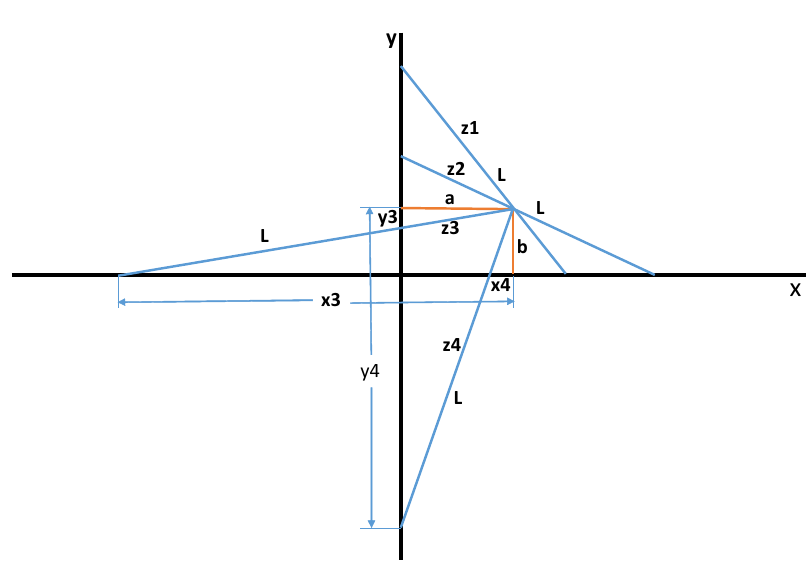
Figure 3. SPL: the four real solutions to the